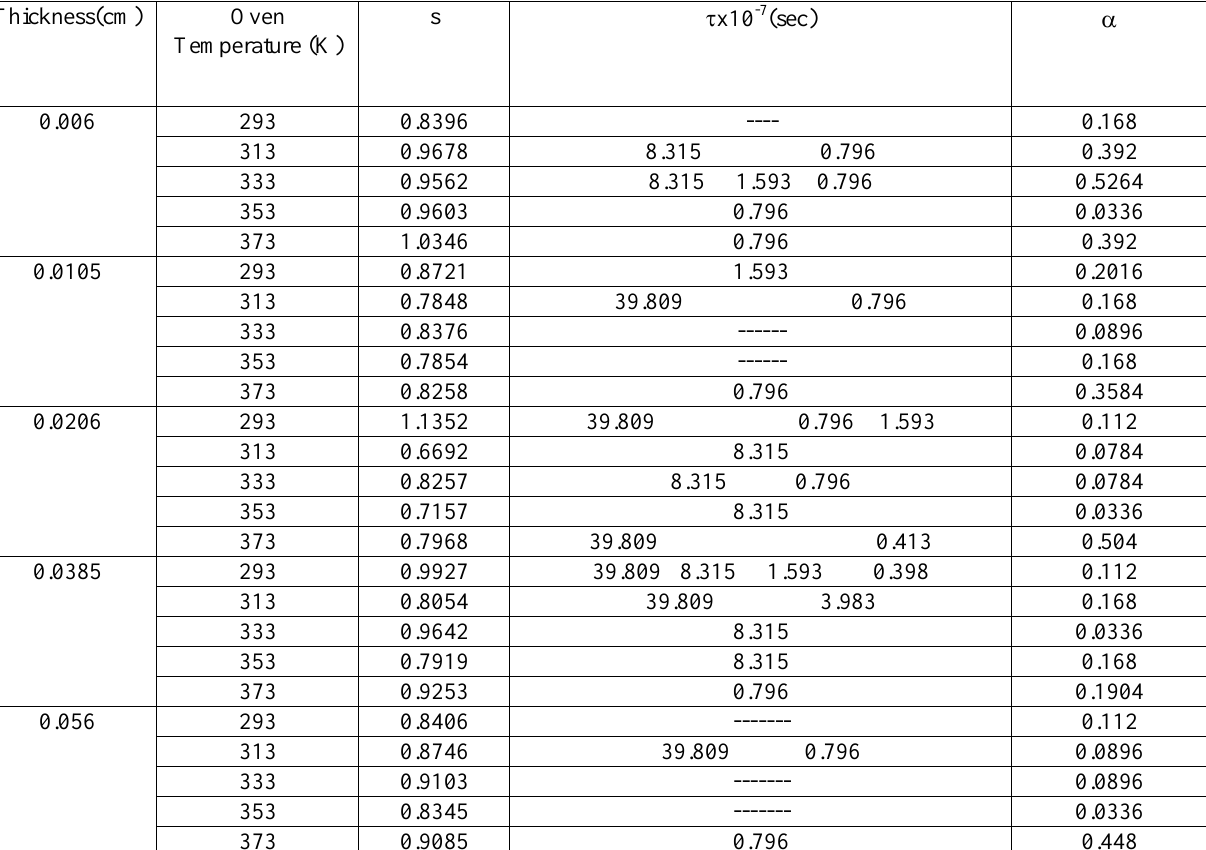
Table1: The values of s,  and  of PMMA